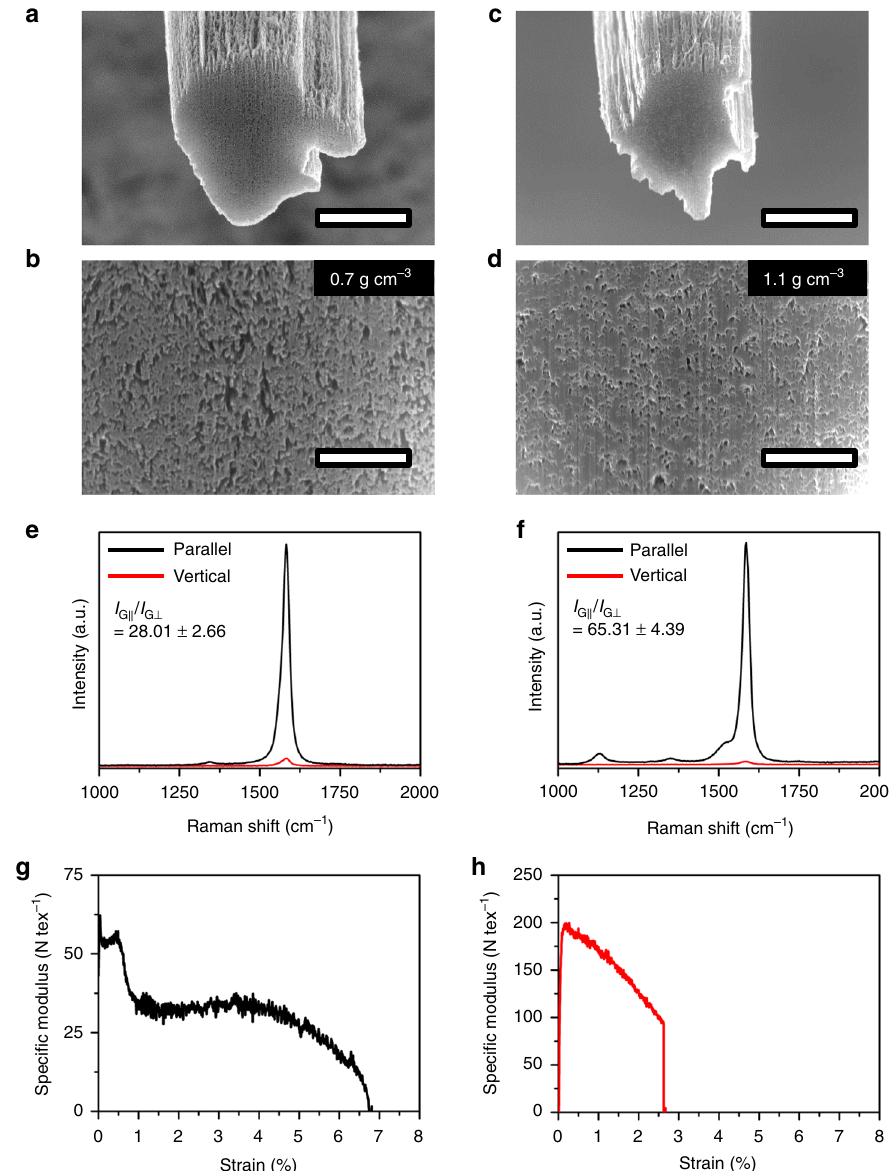
Fig. 5 Structural change of CNTFs with high I G / I D after CSA densi fi cation process. Cross-sectional SEM images of a , b as-spun CNTF and c , d CSA-CNTF. Polarized Raman spectra of e as-spun CNTF and f CSA-CNTF. Speci fi c modulus-strain curves of g as-spun CNTF and h CSA-CNTF. The scale bars in a and c are 5 μ m and those in b and d are 1 μ